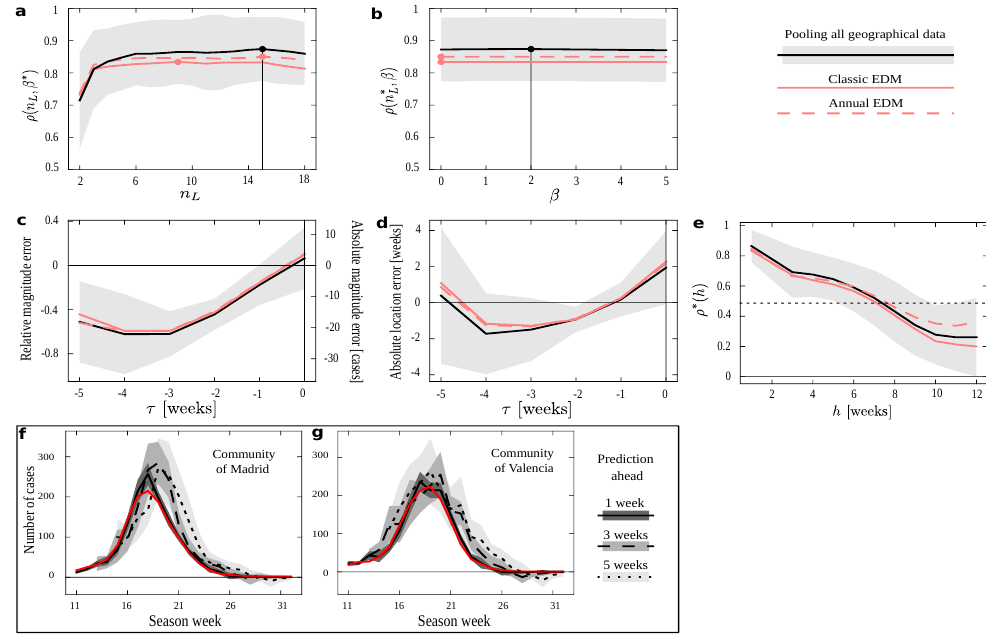
Figure 3. Pooling geographically distributed information for influenza forecast. ( a – e ) Results of different numerical experiments for conditions pool (solid black curves, with shading indicating standard deviation), classic (solid red) and annual (dashed red). Filled circles in ( a , b ) mark the location of optimal meta-parameters for each protocol. The optima for pool are also marked by vertical solid lines. Solid horizontal lines in ( c – f ) mark the 0 of the vertical axis. Solid vertical lines in ( c – e ) mark the location of the peak in time. Dotted horizontal line in f marks ρ ∗ ( h ) = 0.5. ( a ) EDM performance (as measured by correlation between data and forecast) as a function of n L with fixed, optimal β ∗ . ( b ) EDM performance as a function of β with fixed, optimal n L . ( c ) Average error in forecasting the peak magnitude. ( d ) Average error in forecasting the peak location. ( e ) EDM performance as we attempt to predict more time ahead. ( f , g ) Examples of how the forecast become worst as we attempt to predict with more anticipation. Real data (solid red curves) is compared to forecasts derived with one week (solid black), three weeks (dashed black), or five weeks (dotted black) of anticipation. The various shadings indicate standard deviation of the estimated